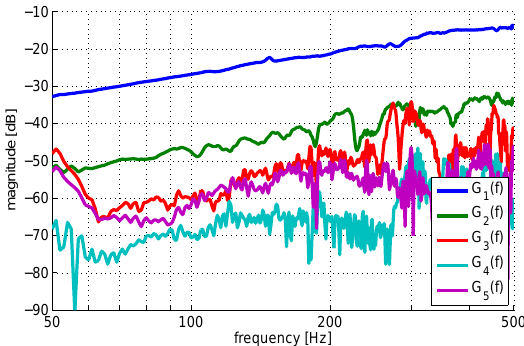
Figure 5. Magnitude values of the estimated filters G n ( f ) of the Generalized Hammerstein model (Figure 2) of the